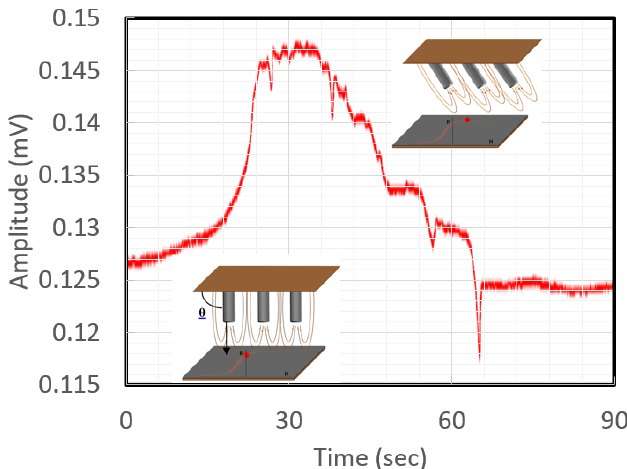
Figure 12. Signal from magnetoresistive sensors at the bottom of a microfluidic channel showing a direct proportionality to flow due to a rapid increase in pressure then a slow release with three sudden drops in pressure and a final backwash from complete pressure release [36].